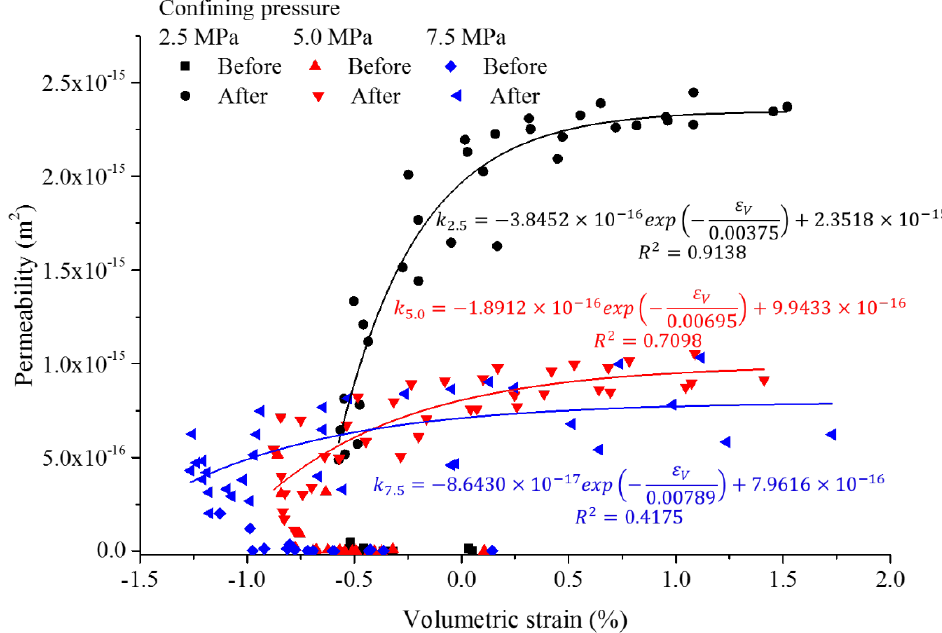
Figure 21. Permeability versus volumetric strain for different confining pressures obtained from numerical simulations (regression curves refer to values after the expansion point).